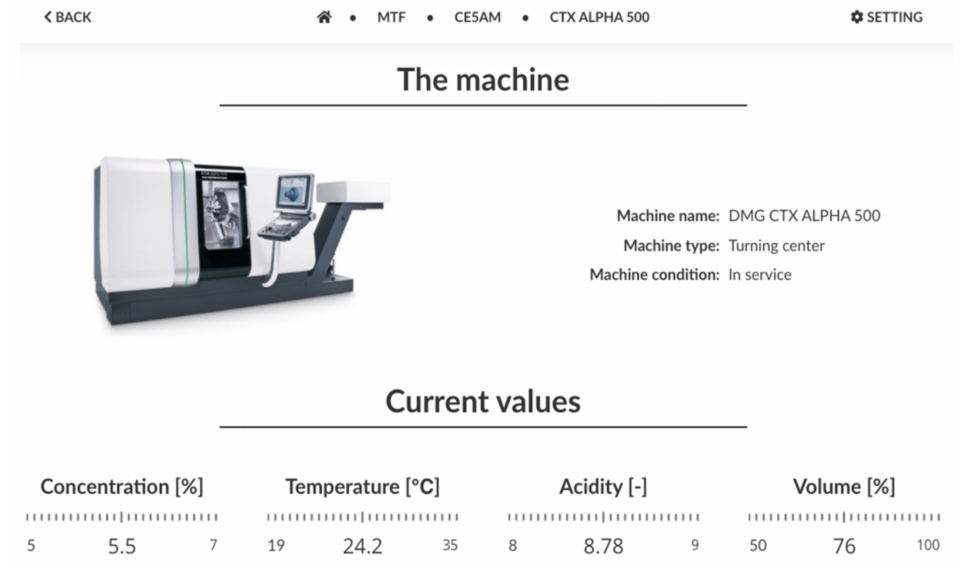
Figure 5. Software—Application